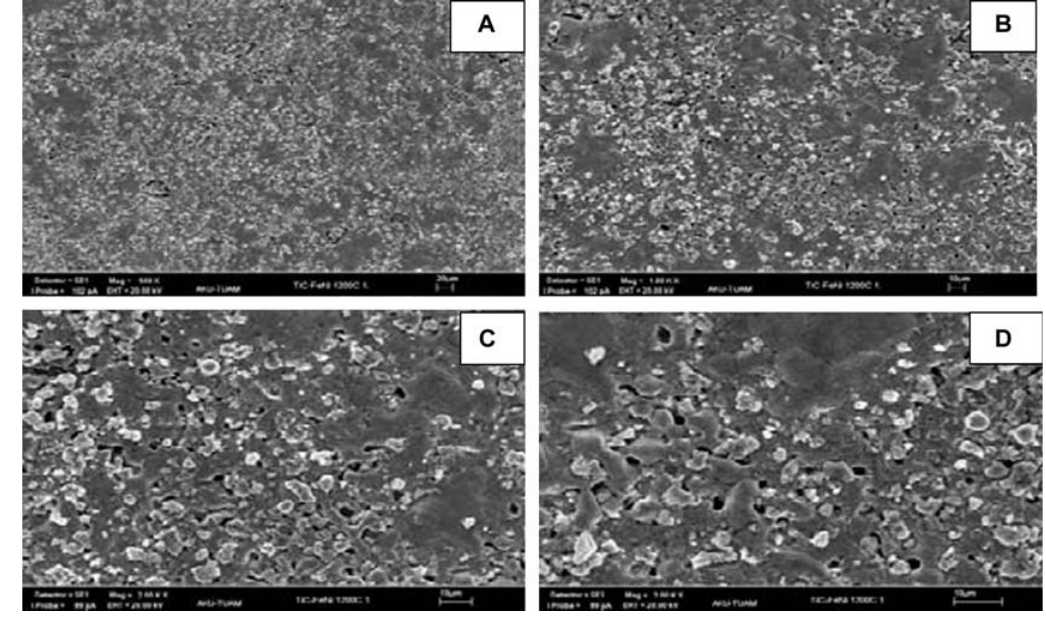
Figure 5 10 % TiC + 90 % (Fe + Ni) 1200 ° C composite SEM